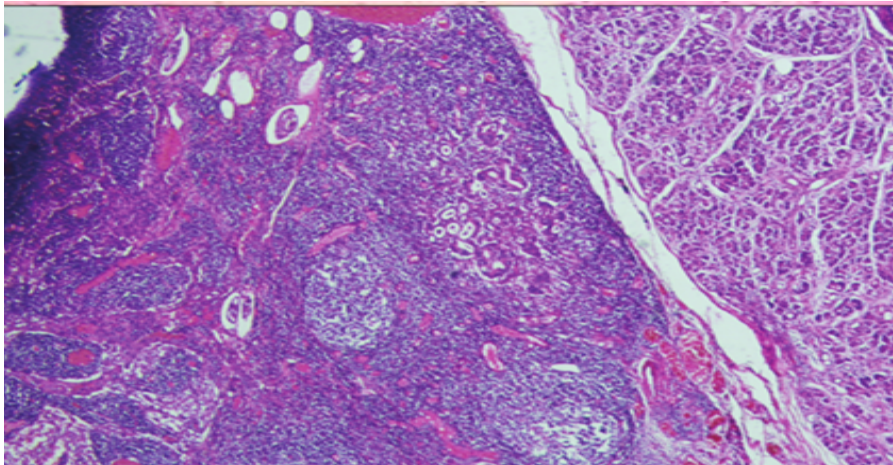
Figure 5 : Metastatic adenocarcinoma to regional lymph nodes H&E stain × 20.